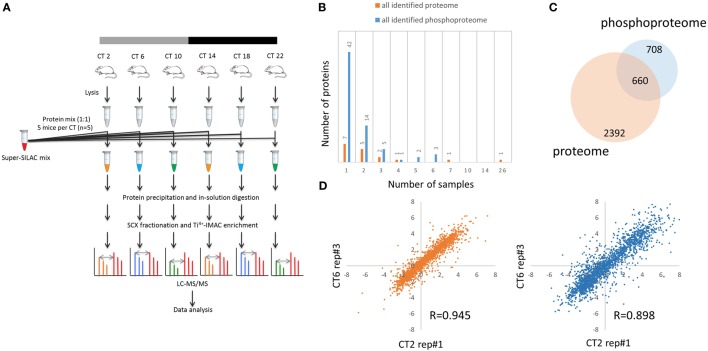
Global proteomic and phosphoproteomic analysis of the murine hippocampus. (A) Schematic overview of super-SILAC-based quantification of the murine hippocampal proteome and phosphoproteome. Proteins extracted from hippocampal tissues of individual mice [n = 5 per circadian time (CT); 6 CT in total] were mixed with equal quantities of protein lysates from a super-SILAC mix (five isotopically labeled cells), digested with trypsin, and processed by SCX fractionation with Ti4+-IMAC chromatography (phosphoproteome analysis) and without (proteome analysis). (B) Plot of 17 proteins and 67 phosphorylation events that were identified in the light (hippocampal tissues), but not heavy (super-SILAC mix), counterpart. x-axis indicates the number of hippocampal samples in which these proteins and phosphosites were detected. (C) Venn diagram indicates that 660 proteins were accurately quantified in both the proteome (orange) and phosphoproteome (blue) datasets, whereas 708 were found only in the phosphoproteome. (D) Representative scatter plots showing biological replicate measurement in proteomic and phosphoproteomic screens with a high degree of correlation among those 30 biological samples.